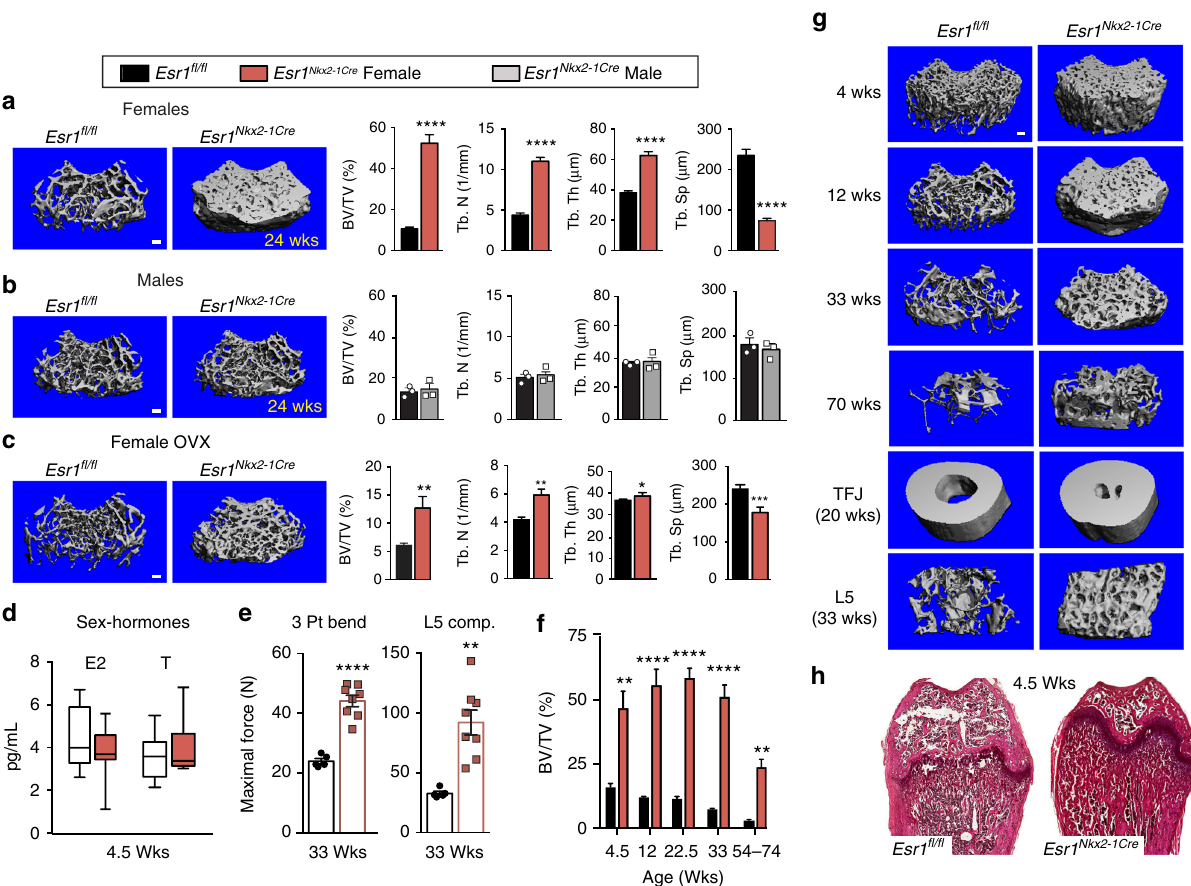
Fig. 2 Sex-dependent increase in bone mass and strength in Esr1 Nkx2-1Cre females. Representative μ CT 3D reconstruction images of distal femurs in ∼ 24- week-old Esr1 fl / fl and Esr1 Nkx2-1Cre a females, b males, and c OVX females (15 – 21 weeks). Right panels show quantitative morphometric properties of distal femurs showing fractional bone volume (BV/TV (%)); trabecular number (Tb. N) trabecular thickness (Tb. Th), and separation (Tb. Sp). For females ( n = 11) controls and ( n = 8) mutants and for males ( n = 3, 3). For OVX ( n = 11) controls and ( n = 8) mutants. Esr1 fl / fl (black boxes), Esr1 Nkx2-1Cre females (red bars) and males (grey bars ) . d LC – MS/MS of plasma E2 and T for Esr1 fl / fl ( n = 9, open box) and Esr1 Nkx2-1Cre ( n = 11, red box) juvenile females at 4.5 weeks of age (center line = median; bounds extend minimum to maximum). e Scatter plot of mechanical testing of distal femurs and L5 vertebral bodies (33 weeks) Esr1 fl / fl (black squares), Esr1 Nkx2-1Cre (red squares). f BV/TV (%) of the distal femur generated by either μ CT or 2D histomorphometric analysis over time from 4.5 weeks of age to 54 – 74 weeks of age, for genotype ( F 1,50 = 172.1, p < 0.0001), animal number in each Esr1 fl / fl and Esr1 Nkx2-1Cre group for 4.5 weeks ( n = 3, 4), 12 weeks ( n = 5, 6), 22.5 weeks (4, 5), 33 weeks (7, 9), and 54 + weeks (9, 7). g Representative μ CT images of age-dependent changes in femoral bone mass, as well as image of cortical bone at the tibial fi bular joint (TFJ) in females (20 weeks), and L5 vertebral bodies (33 weeks) in Esr1 fl / fl and Esr1 Nkx2-1Cre females. h Representative H&E staining of female femurs from Esr1 fl / fl and Esr1 Nkx2-1Cre juvenile females at 4.5 weeks. Error bars are ±SEM (standard error of the mean). Two-way ANOVA ( e ), Unpaired Student ’ s t test ( a – d , f ). * p < 0.05; ** p < 0.01; *** p < 0.001; **** p < 0.0001. Scale bars